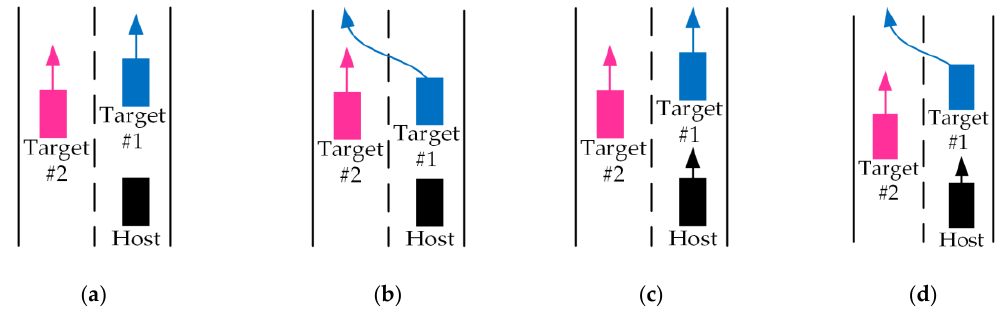
Figure 4. Test scenarios. ( a ) Scenario 1; ( b ) Scenario 2; ( c ) Scenario 3; ( d ) Scenario 4.